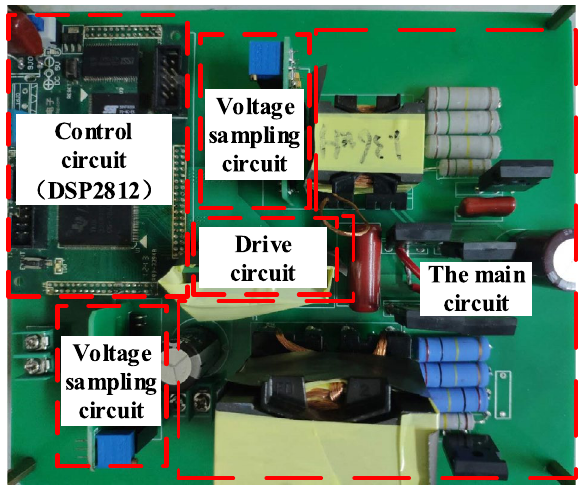
Figure 18. Prototype of the converters.